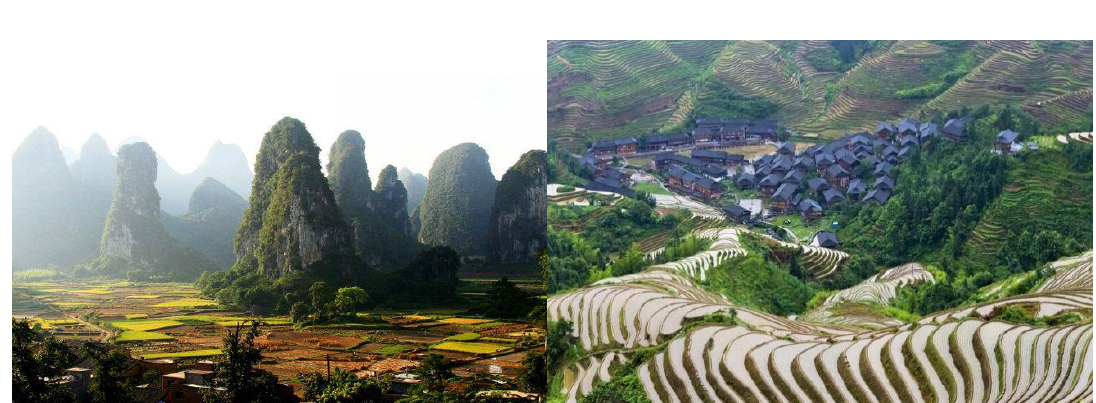
Figure 2. (Left ) Guangxi is famous for its scenic beauty but arable land is in short supply and multi-layered terraces are common, as shown in the photo to the right . New urbanized clusters are now appearing in the countryside as cropland is consolidated.